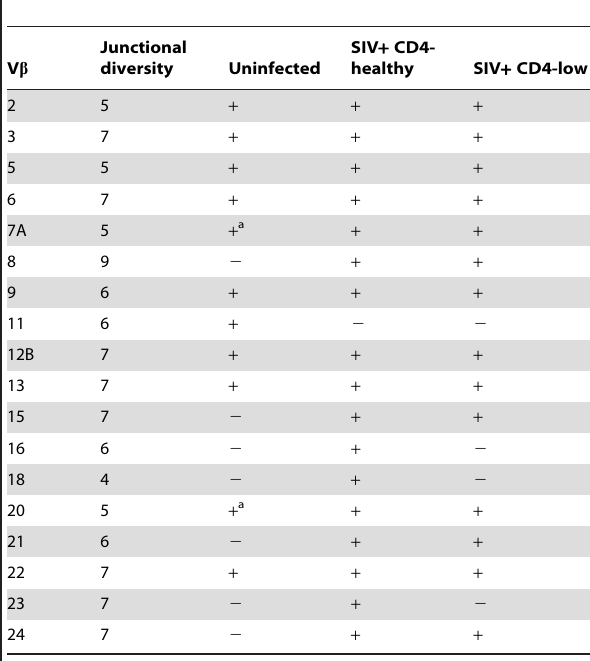
Table 1. Spectratyping analysis of DN T cells from SIV infected and uninfected